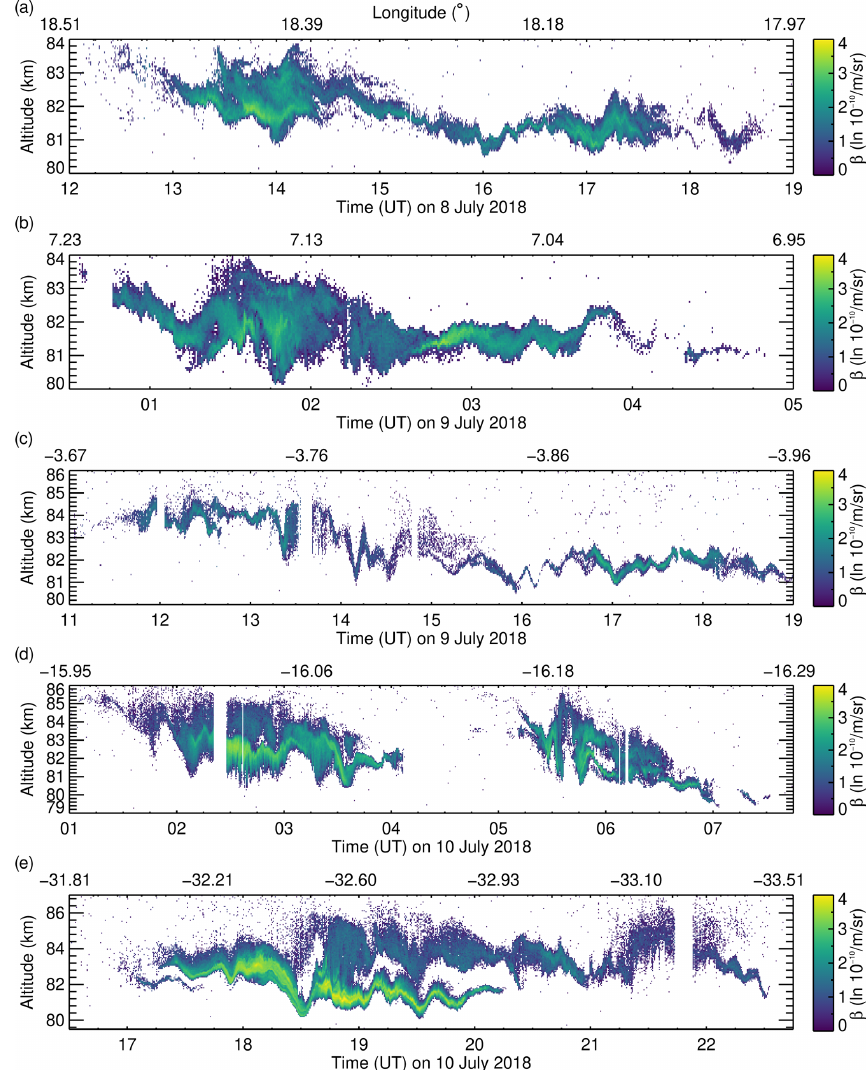
Figure 6. Part I of selected PMC altitude–time sections which are part of the PMC Turbo BOLIDE dataset. Short gaps in the lidar soundings are due to missing